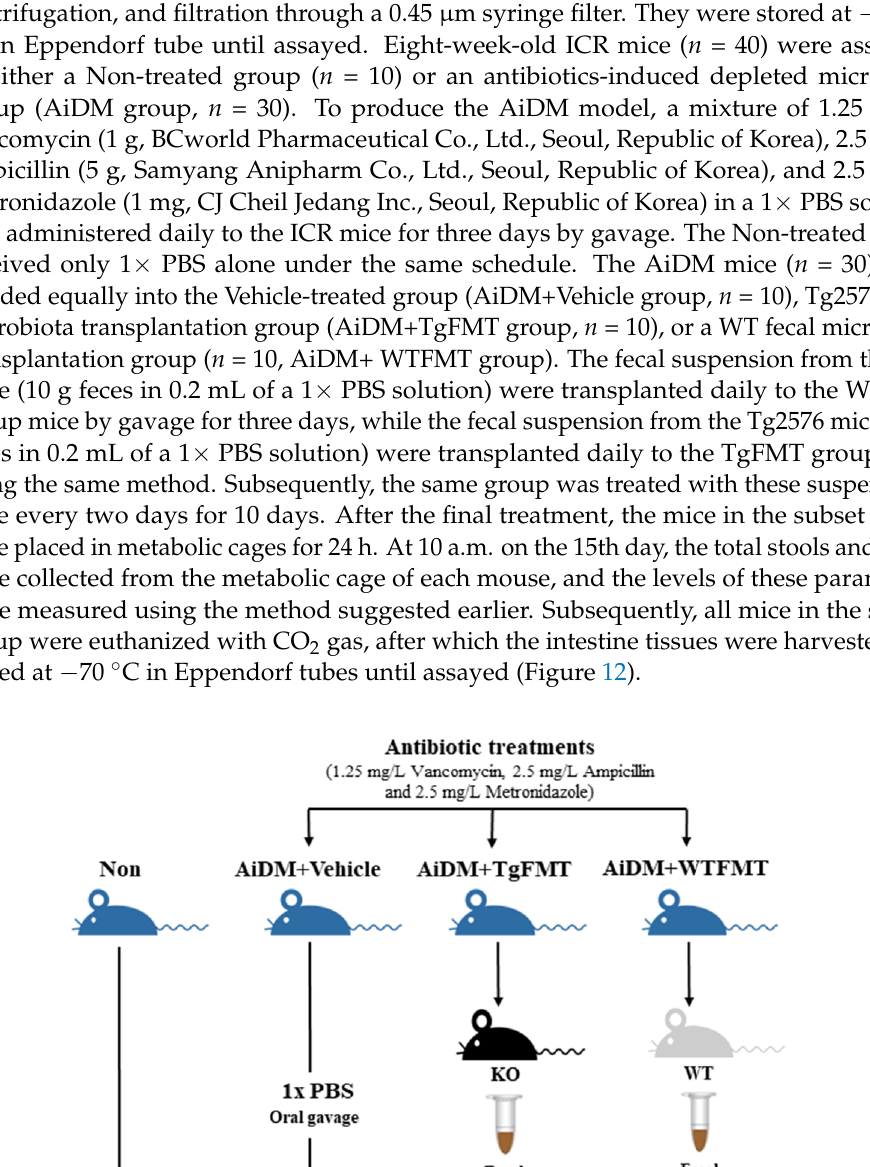
Figure 12. Experimental scheme for the FMT of the Tg2576 mice. ( a ) Treatment strategy. The WT and Tg2576 mice were divided into one of four groups: Non, AiDM+Vehicle, AiDM+TgFMT, and AiDM+WTFMT groups. The AiDM groups received the appropriate concentration of three antibi- otics (vancomycin, ampicillin, and metronidazole) to remove intestinal bacteria. ( b ) Treatment schedule for FMT. After treatment with the three antibiotics for three days, the fecal suspensions of WT or Tg2576 mice were administrated orally into the AiDM-ICR mice seven times over two weeks. Abbreviations: WT, wild-type; Tg, Tg2576 mice; FMT, fecal microbiota transplantation; TgFMT, Tg2576 mice FMT; WTFMT, wild-type mice FMT; AiDM, antibiotics-induced depletion of microbi- ota. 4.8. Culture of Fecal-Derived Microbiota The growth of microorganisms derived from the fecal samples of the WT and Tg2576 mice was measured using the viable cell count method. After collecting the feces samples from the mice of a subset group, they were suspended and serially diluted 1,000 – 10,000 fold with sterile water. Each diluent was inoculated and spread on a nutrient agar plate comprised of peptone (0.5%), beef extract/yeast extract (0.3%), agar (1.5%), and NaCl (0.5%), and aerobically incubated at 30°C for 24 h. The growth pattern of the bacteria col- onies in the nutrient agar plate was observed on the view box. 4.9. Quantitative Real-Time PCR Analysis (RT-qPCR) The relative quantities of AQP3, AQP8, 5-HT 2A, 5-HT 2B, 5-HT 3A, and 5-HT 3B mRNAs were determined with RT-qPCR, as described in a previous study [40]. After iso-